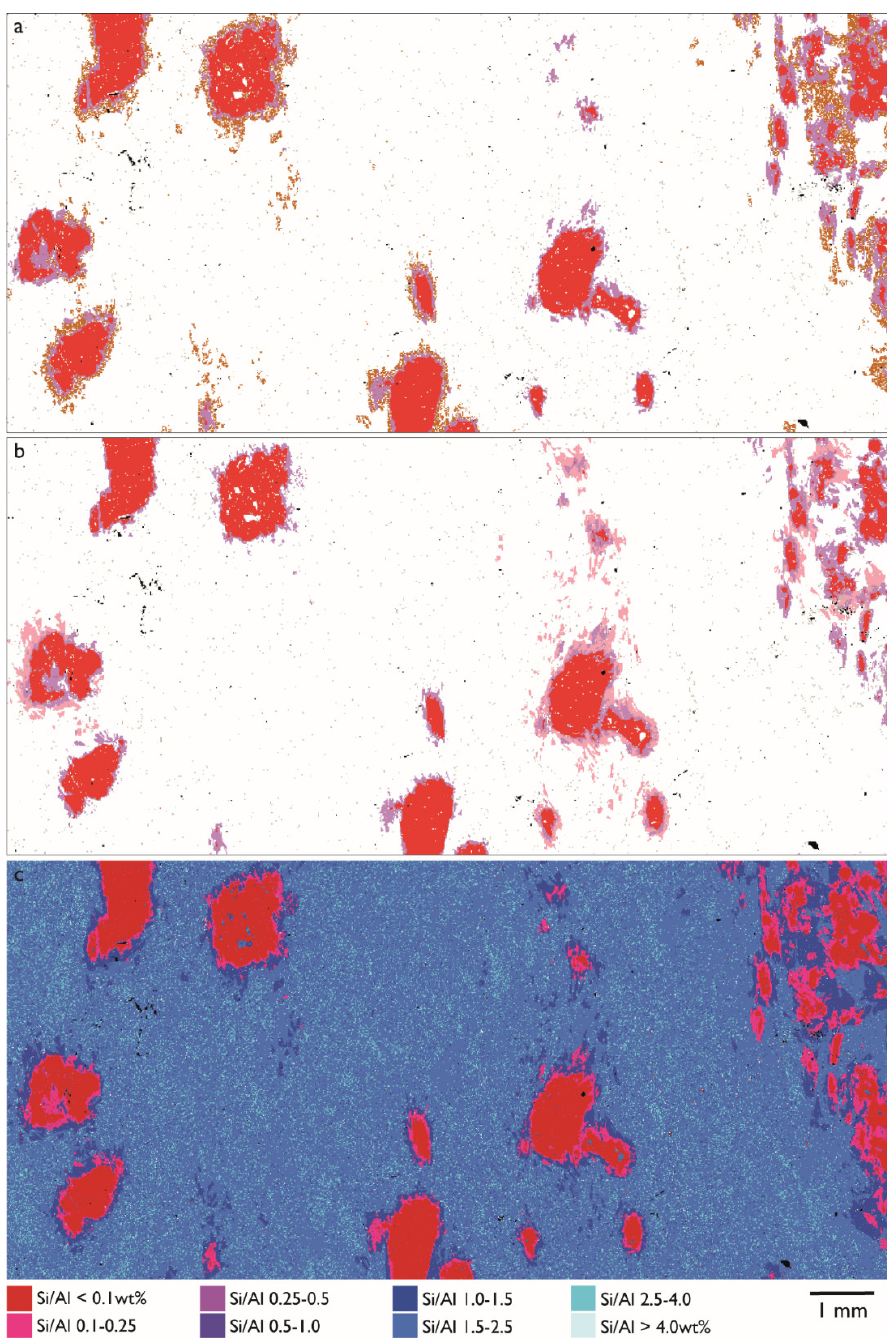
Figure 10. Detail of the sample displayed in Figure 9. ( a ) Corundum-sapphire-cordierite association map. ( b ) Corundum-sapphirine-anorthite association map. All other minerals are displayed in white. ( c ) Element ratio map showing the Si / Al ratios in the sample. wt% indicates that wt% data were used to calculate the ratios. Legend for (a) and (b) in Figure 9.